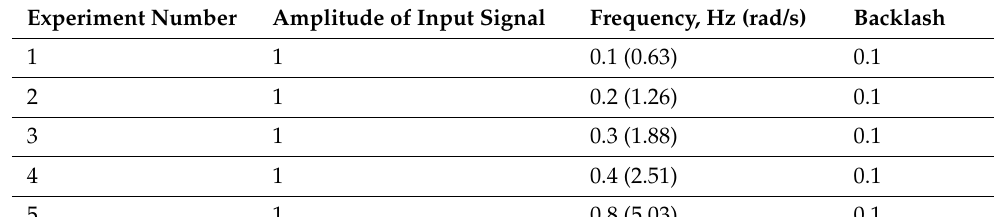
Table A1. Initial data. Table 1. Initial data.